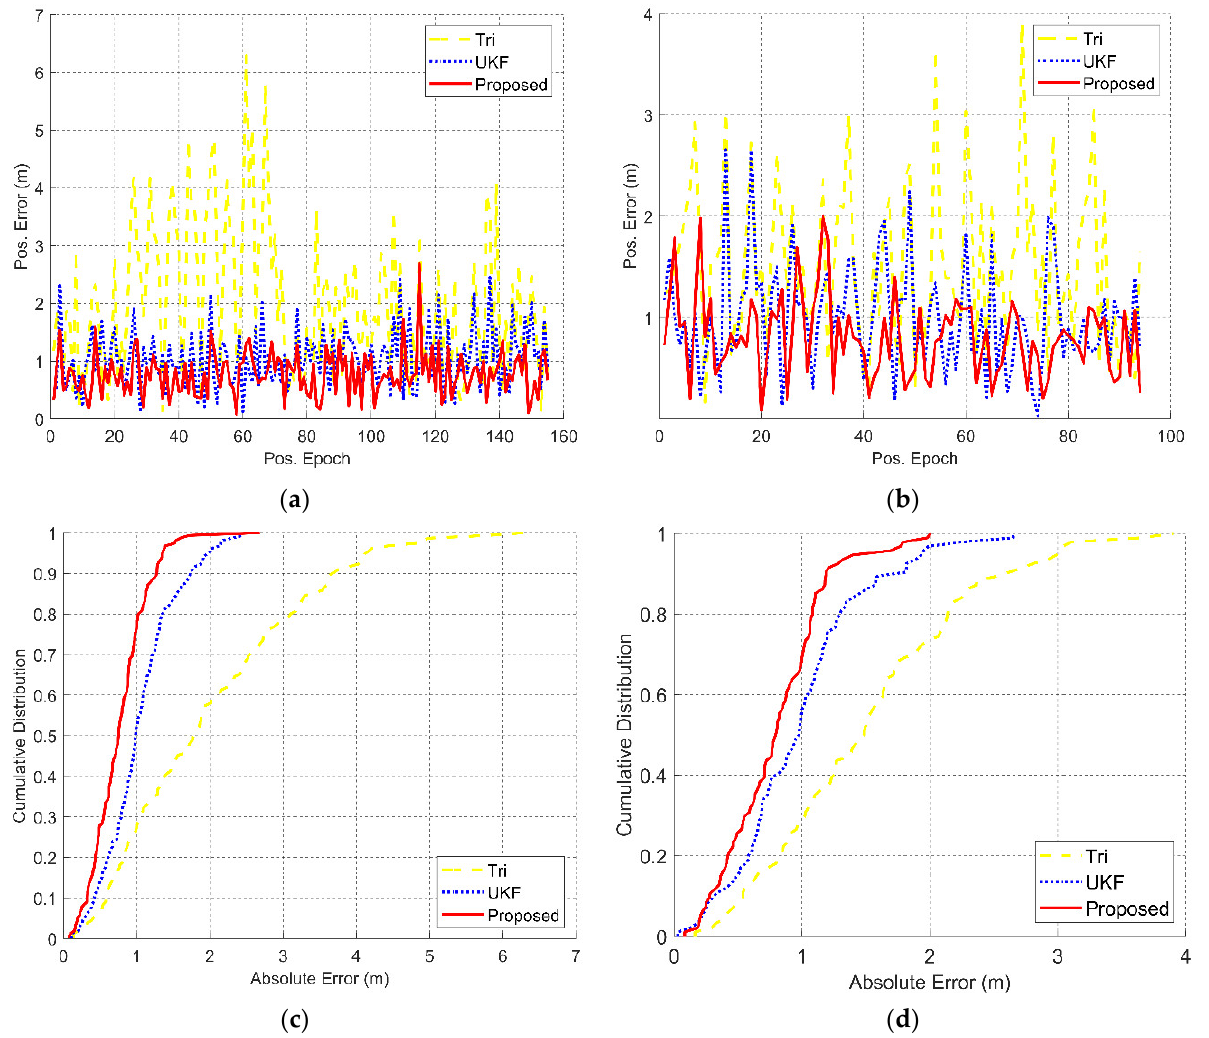
Figure 7. Comparison of ranging error versus time epoch between BLE unit-based and MMBB-based methods. ( a ) Positioning error of Test 1 ( b ) Positioning error of Test 2 ( c ) Cumulative error percentages of Test 1 ( d ) Cumulative error percentages of Test 2. Table 3. Position error comparison.